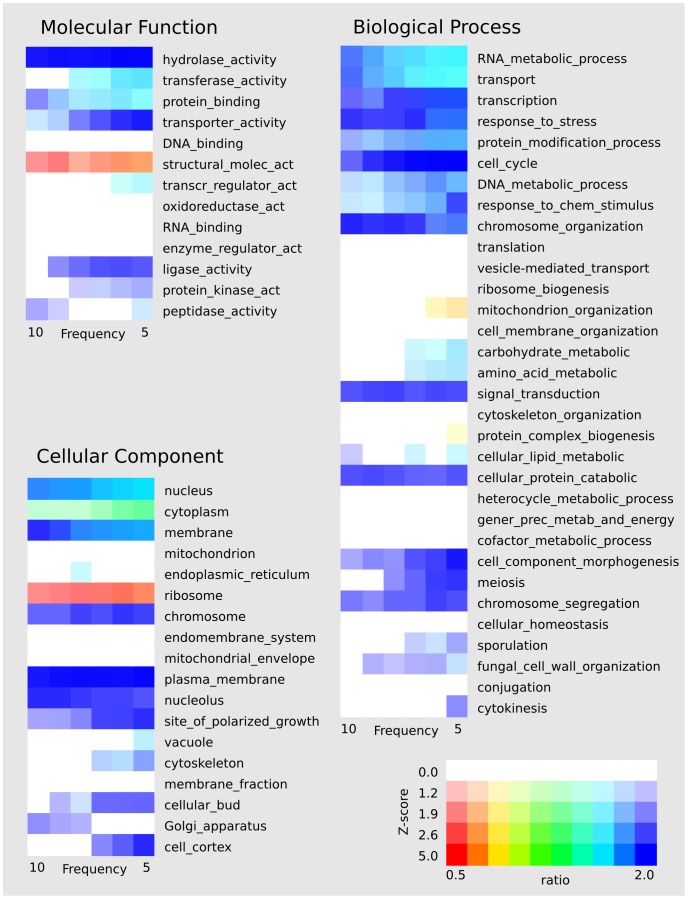
The distribution of inter-chromosomal contacts within groups of genes by GO-slim terms.The distribution is characterized by the ratio of the observed number of linked genes for each GO term to that of the number predicted from Monte Carlo simulation. The ratio is shown here by the hue of the color, where blue and purple correspond to high ratios (or enriched terms) and orange and red to low ratios (depleted terms). The significance of the ratio is represented here by the saturation of the colour as shown in the legend. The GO terms are divided into the three main domains and sorted according to their number of genes. The ratios are provided for all terms at different threshold count frequencies in the experimental link data with the two libraries combined.